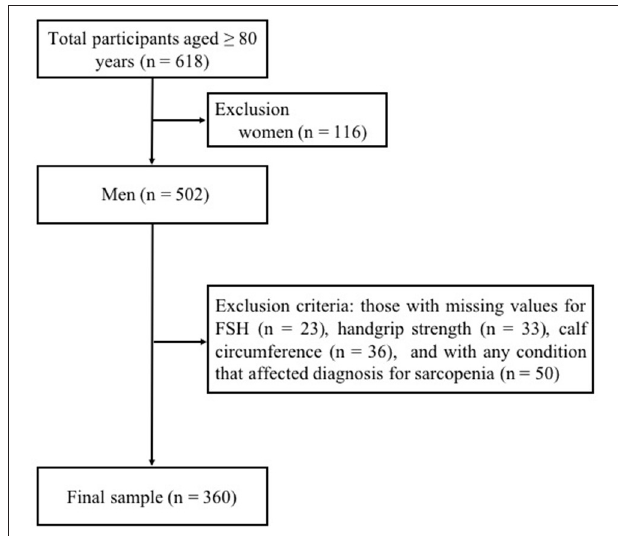
FIGURE 1 | Flowchart for participants enrolled in this